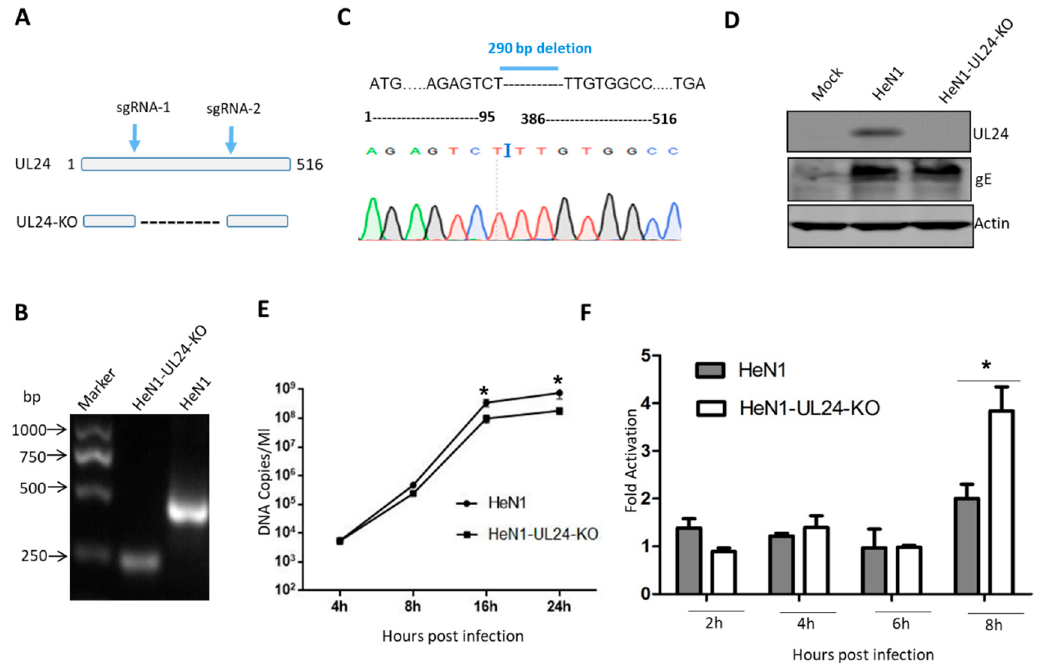
Figure 2. Deletion of UL24 promotes NF- κ B activation. ( A ) Diagram of the PRV UL24 gene, with the sgRNA1 and sgRNA2 incision positions. ( B ) The UL24 knockout virus was identified by PCR. Several clones were randomly chosen and cultured in Vero cells, and the virus genome was extracted and identified by PCR with the primers. ( C ) UL24 knockout was confirmed by DNA sequencing; 290 bases were deleted from 96~385 bp of the UL24 gene. The deletion region is shown as a dotted line. ( D ) UL24 knockout was confirmed by Western blot. ( E ) The HEK293 cells were inoculated with WT PRV or UL24 knockout PRV at a multiple of infection (MOI) of 0.1. The virus was collected at 4, 8, 16, and 24 h post infection. qPCR was used to quantify the copy numbers of viral DNA. ( F ) HEK293T cells were transfected with an NF- κ B-Luc reporter plasmid. Twelve hours later, the cells were infected with HeN1 PRV or UL24 knockout PRV (MOI = 10), and luciferase activity was measured at 2 h, 4 h, 6 h, and 8 h post infection. The experiments were performed three times, and a representative result is shown. * indicates p < 0.05.